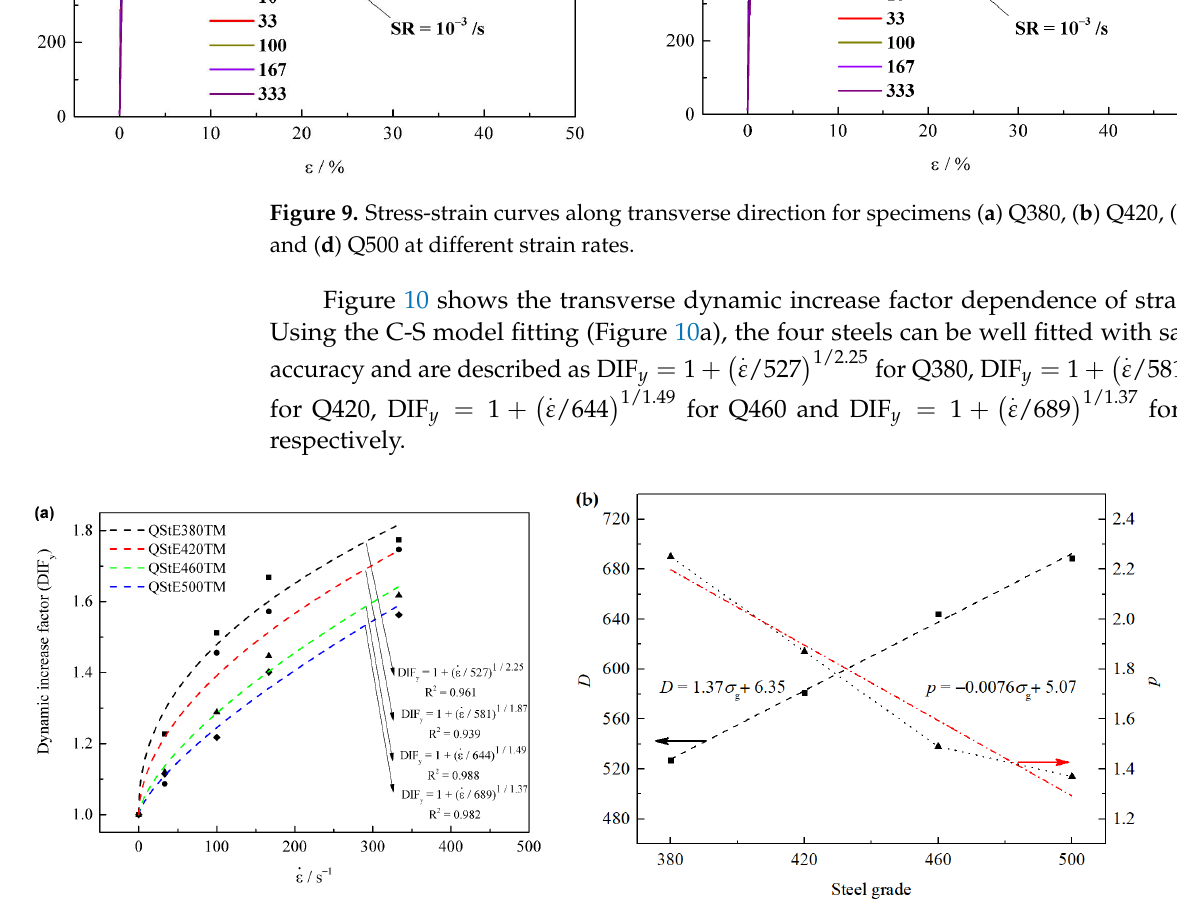
Figure 10. The C-S model fitting curves for steels along transvers direction, ( a ) fitting results, ( b ) D and p dependence of steel grade 𝜎 (cid:2917) , where the two arrows are pointed to two Y-axes of D and p ， respectively.